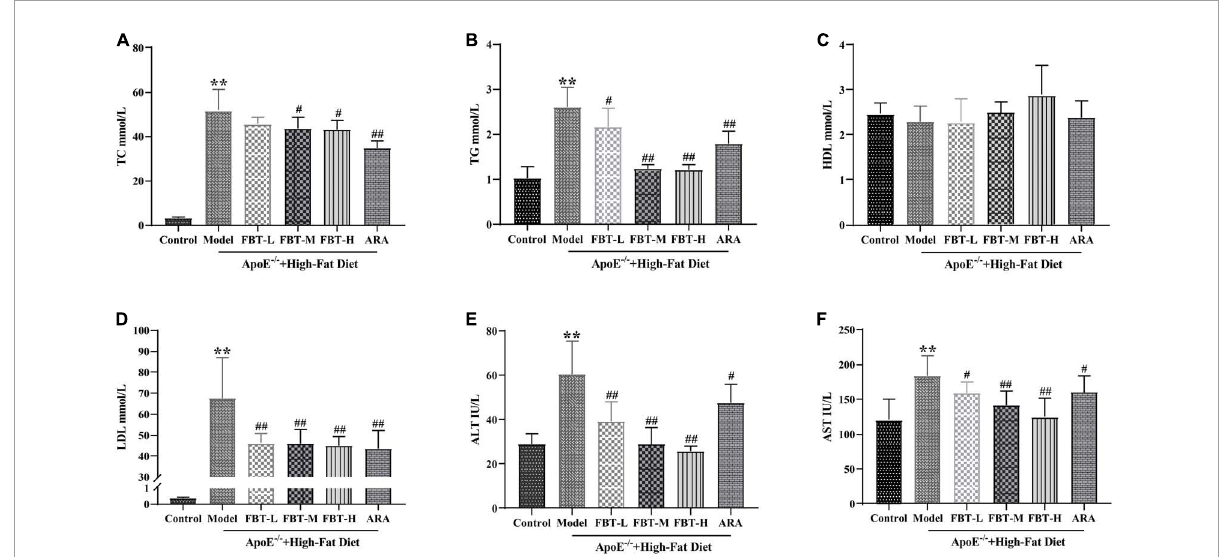
FIGURE3 Effects of FBT on blood lipids and liver function of NAFLD mice. (A) FBT treatment decreased TC in NAFLD mice; (B) FBT treatment decreased TG in NAFLD mice; (C) FBT treatment had no significant effect on HDL in NAFLD mice; (D) FBT treatment decreased LDL in NAFLD mice; (E) FBT treatment decreased ALT in NAFLD mice; (F) FBT treatment decreased AST in NAFLD mice. ** P < 0.01 vs. control group. N = 12. # P < 0.05, ## p < 0.01 vs. model